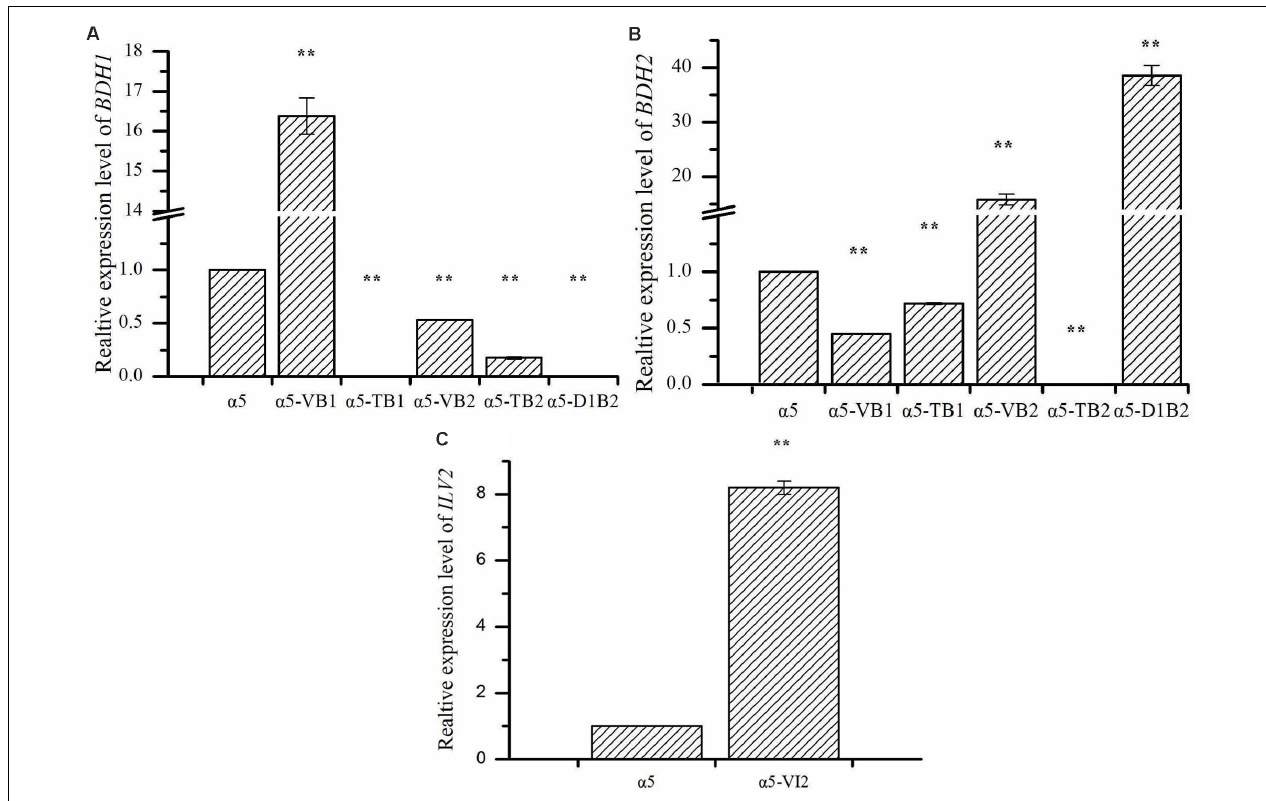
FIGURE 2 | The relative expression levels of BDH1 , BDH2 , and ILV2 . (A) The relative expression of BDH1 in strain α 5, α 5-VB1, α 5-TB1, α 5-VB2, α 5-TB2, and α 5-D1B2. (B) The relative expression of BDH2 in strain α 5, α 5-VB1, α 5-TB1, α 5-VB2, α 5-TB2, and α 5-D1B2. (C) The relative expression of ILV2 in strain α 5 and α 5-VI2. Data represent the mean of three independent biological replicates. Error bars represent the SD of the average values. Statistical significance is denoted as ** P < 0.01 and ** P < 0.05.